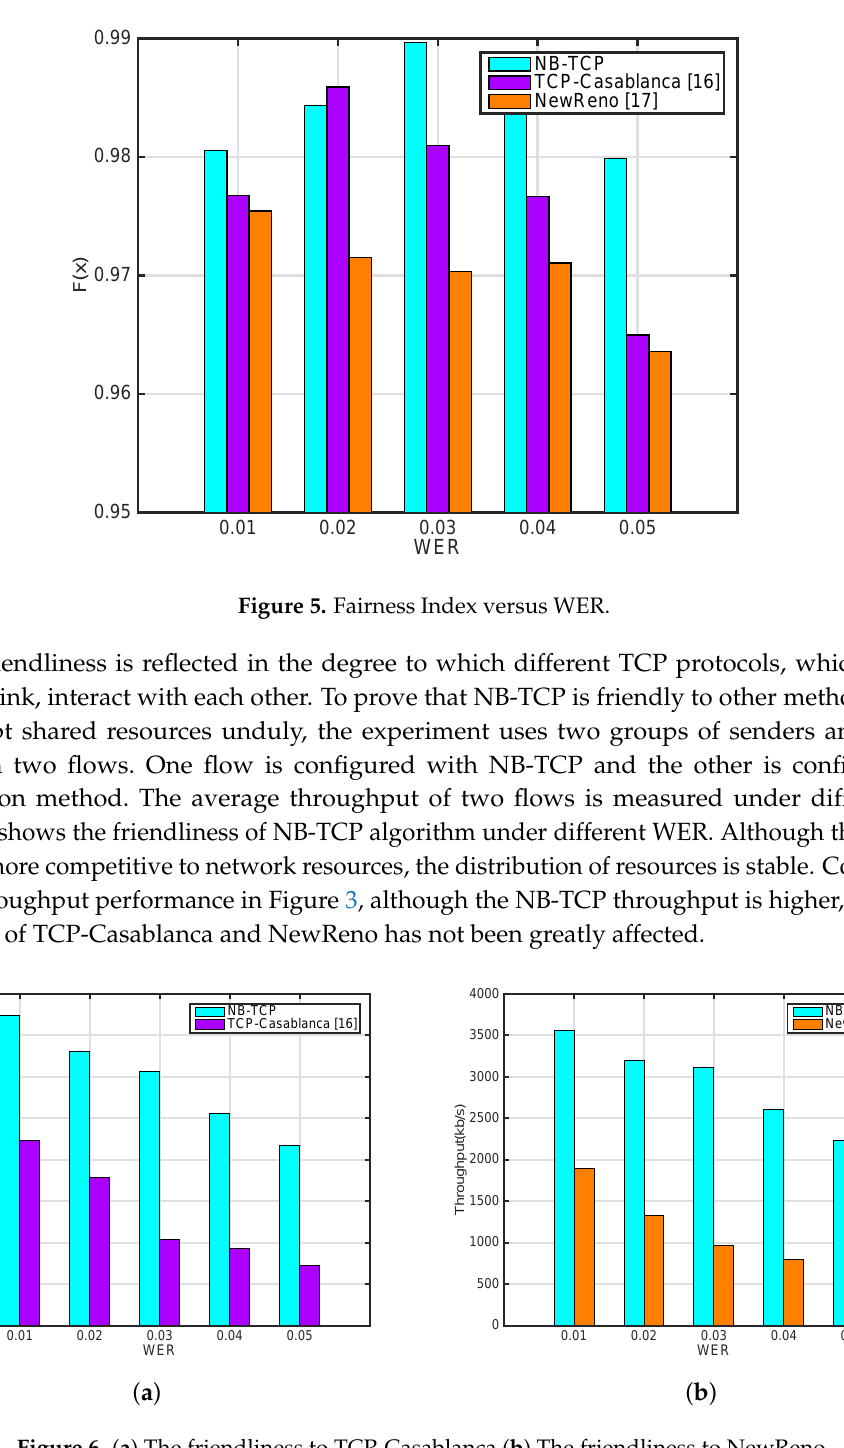
Figure 6. ( a ) The friendliness to TCP-Casablanca ( b ) The friendliness to